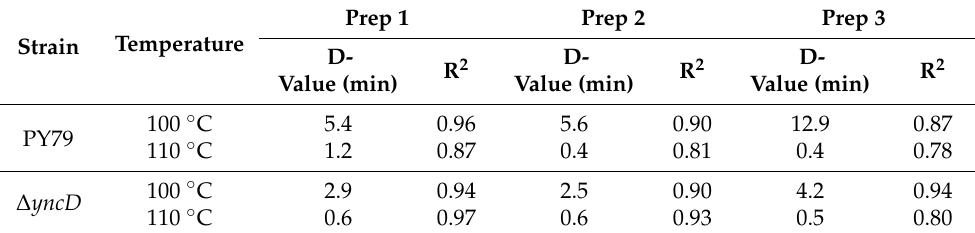
Table 2. Heat resistance of the wild-type and ∆ yncD spores. D -values were calculated using a log-linear model for three independent spore preparations at 100 ◦ C and 110 ◦ C. R 2 is a regression statistic which reflects how well the regression predictions agree with the real data. The closer this value is to the value 1, the closer the measured points are to the calculated ones.